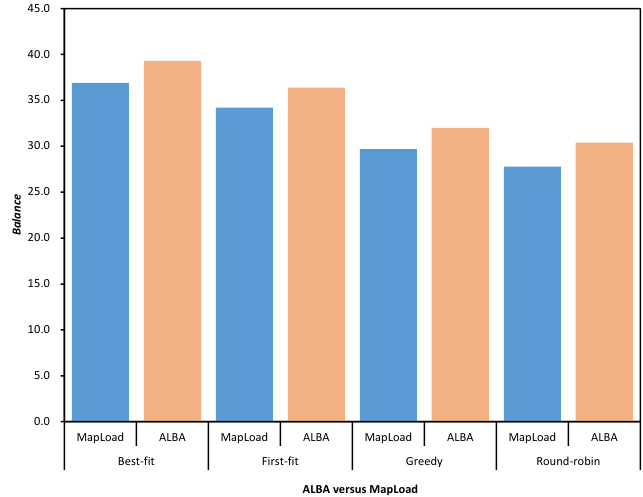
Figure 6. Load balancing comparison of ALBA and MapLoad.